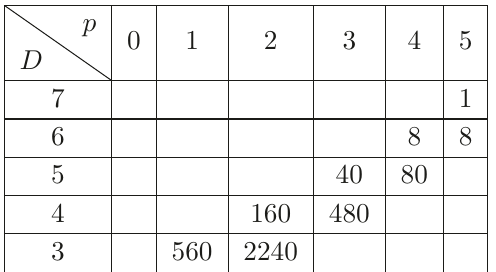
Table 3 . The F 9 , 3 family of branes, whose number is obtained starting from the 5-brane in D = 7 by doubling times a multiplicity factor